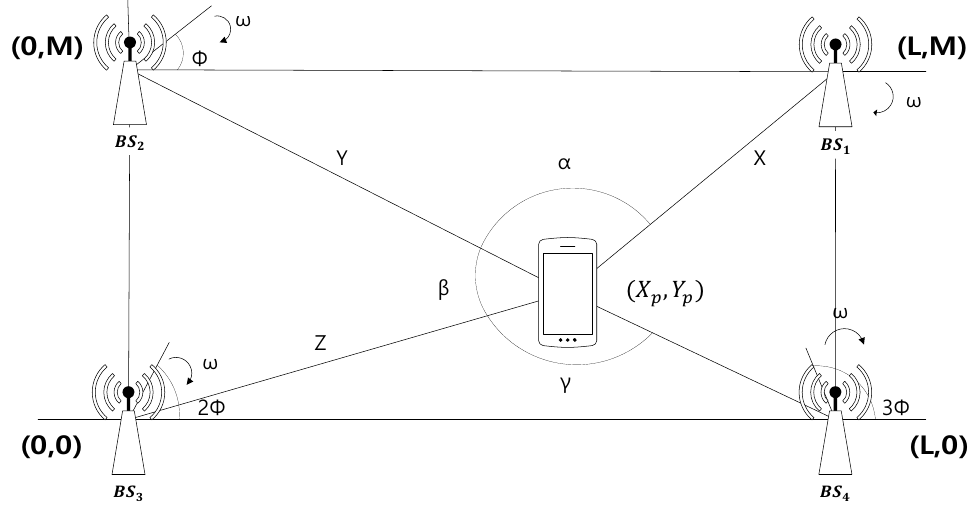
Figure 1. The Angle of Arrival (AoA)